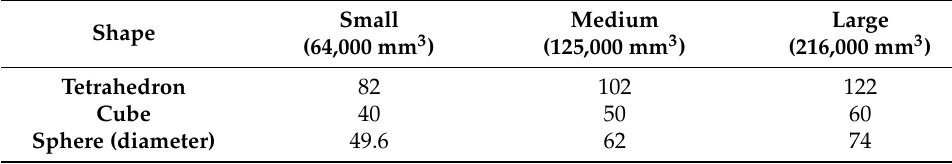
Table 2. One side length of objects for three shapes (mm).